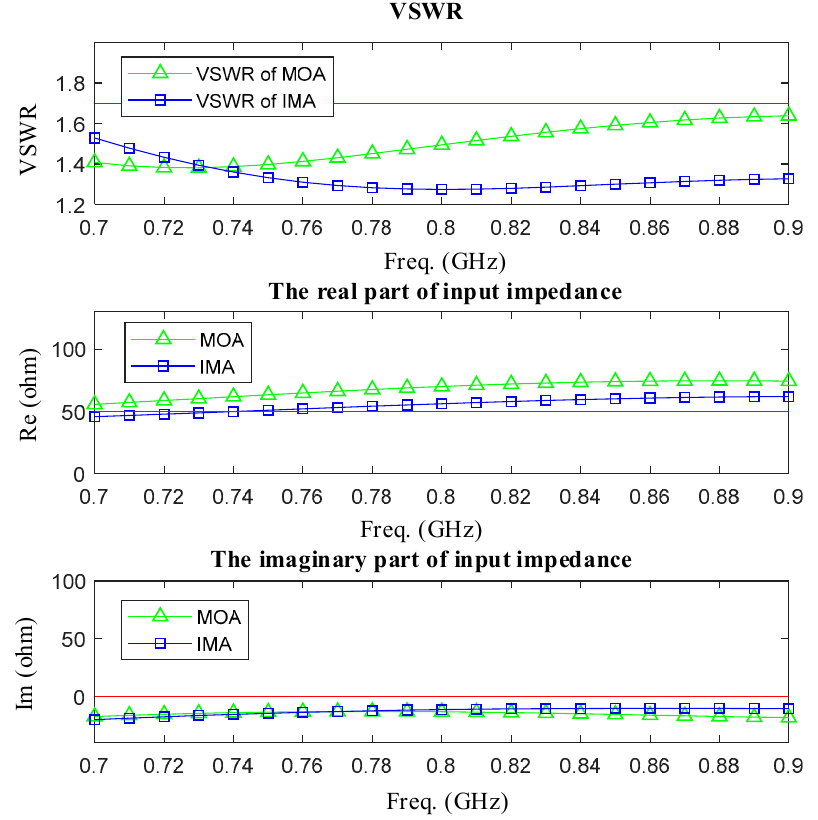
Figure 12. The simulated VSWR and input impedance of MOA and IMA are shown upon.